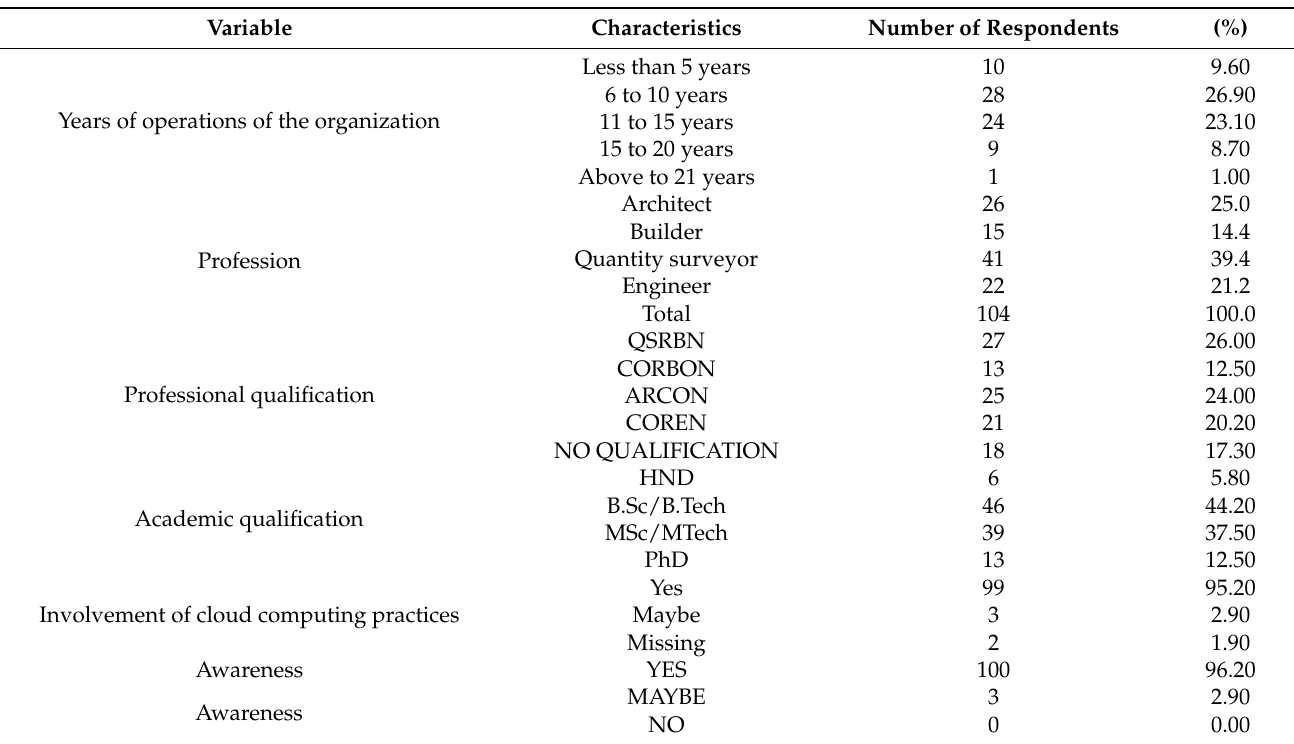
Table 2. Demographic characteristic frequency